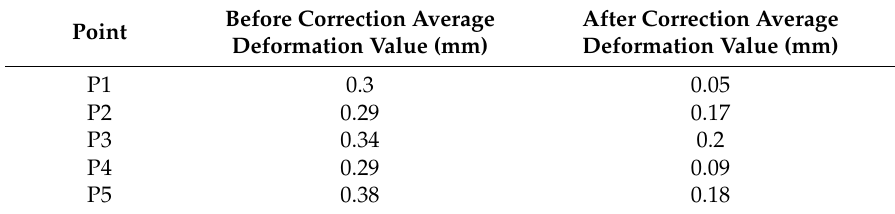
Table 2. Comparison of average displacements of five PS points before and after atmospheric correction.